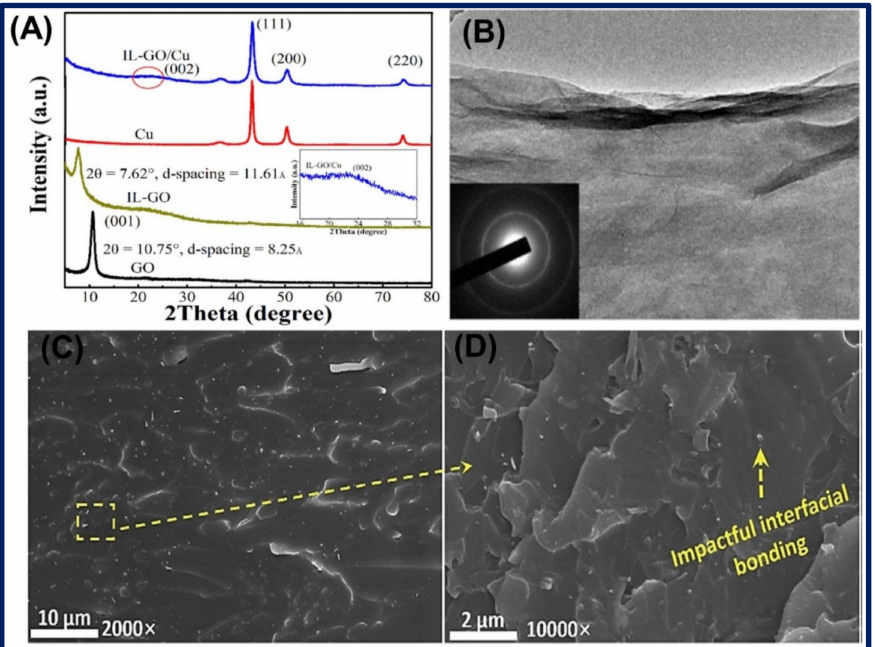
Figure 6. ( A ) XRD patterns of GO, GO-ILs, Cu, and GO-ILs/CuNPs. ( B ) TEM image of GO-ILs. Reprinted with permission from Ref. [71]. Copyright 2019, Elsevier. ( C , D ) SEM images of the fracture surface of EP/AIL-MWCNTs composites at 2.0 wt.% filler contents. Reprinted with permission from Ref. [72]. Copyright 2019,